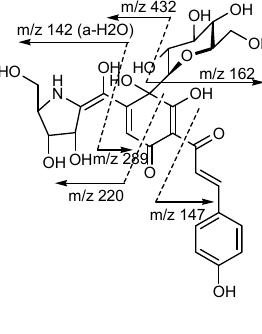
Figure 4. The linked scan FAB-MS of tinctormin in positive ion mode